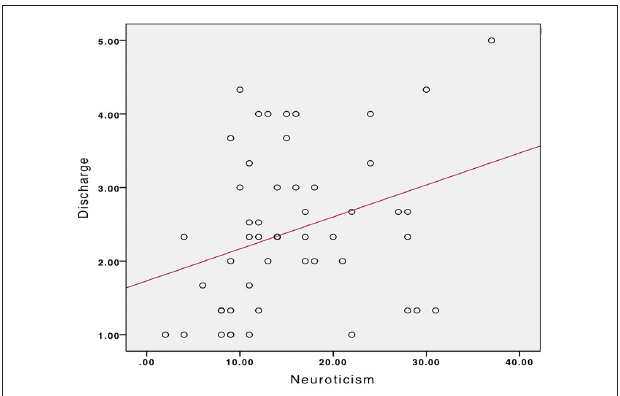
FIGURE 3 | Relationship between Neuroticism and Discharge in